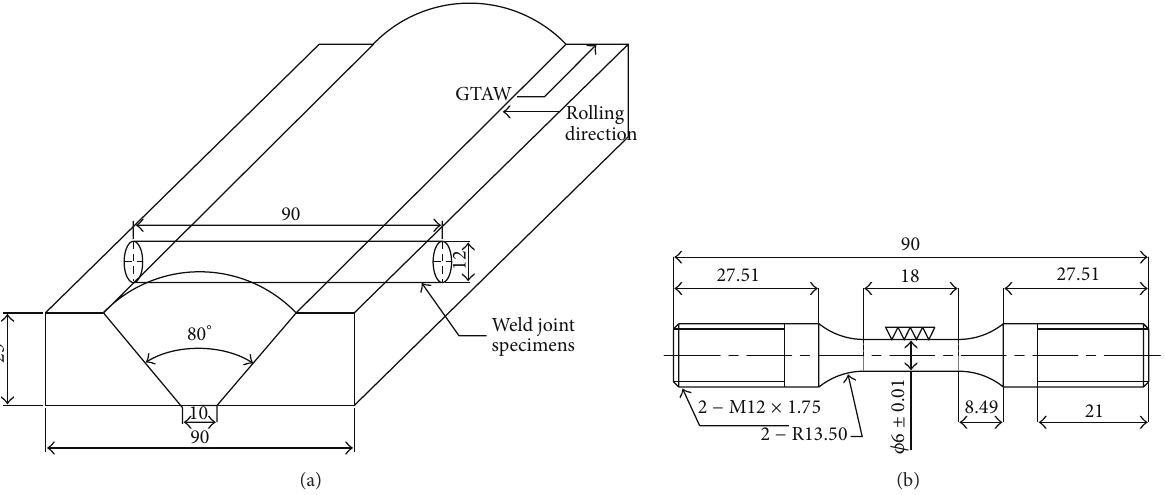
Figure 1: (a) The weld pad configuration for WJ specimen. (b) The cylindrical specimen’s shape and dimension for Alloy 617 BM and Alloy 617 WJ.